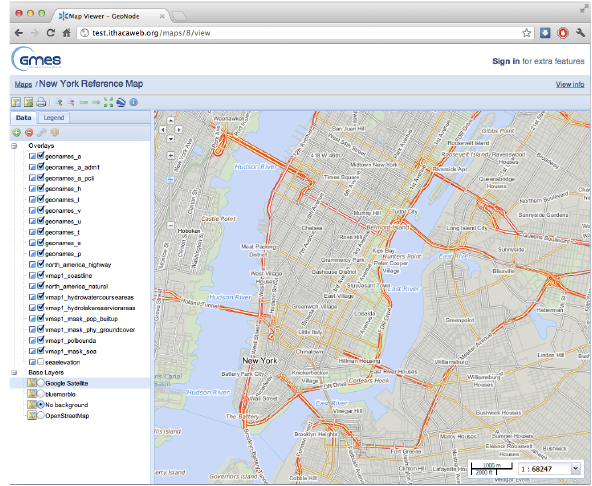
Figure 10. A map as a combination of layers